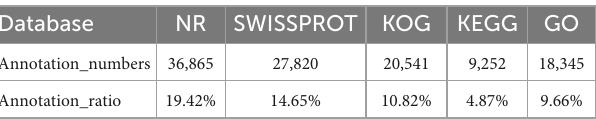
TABLE 2 The statistical results of annotation proportions of each